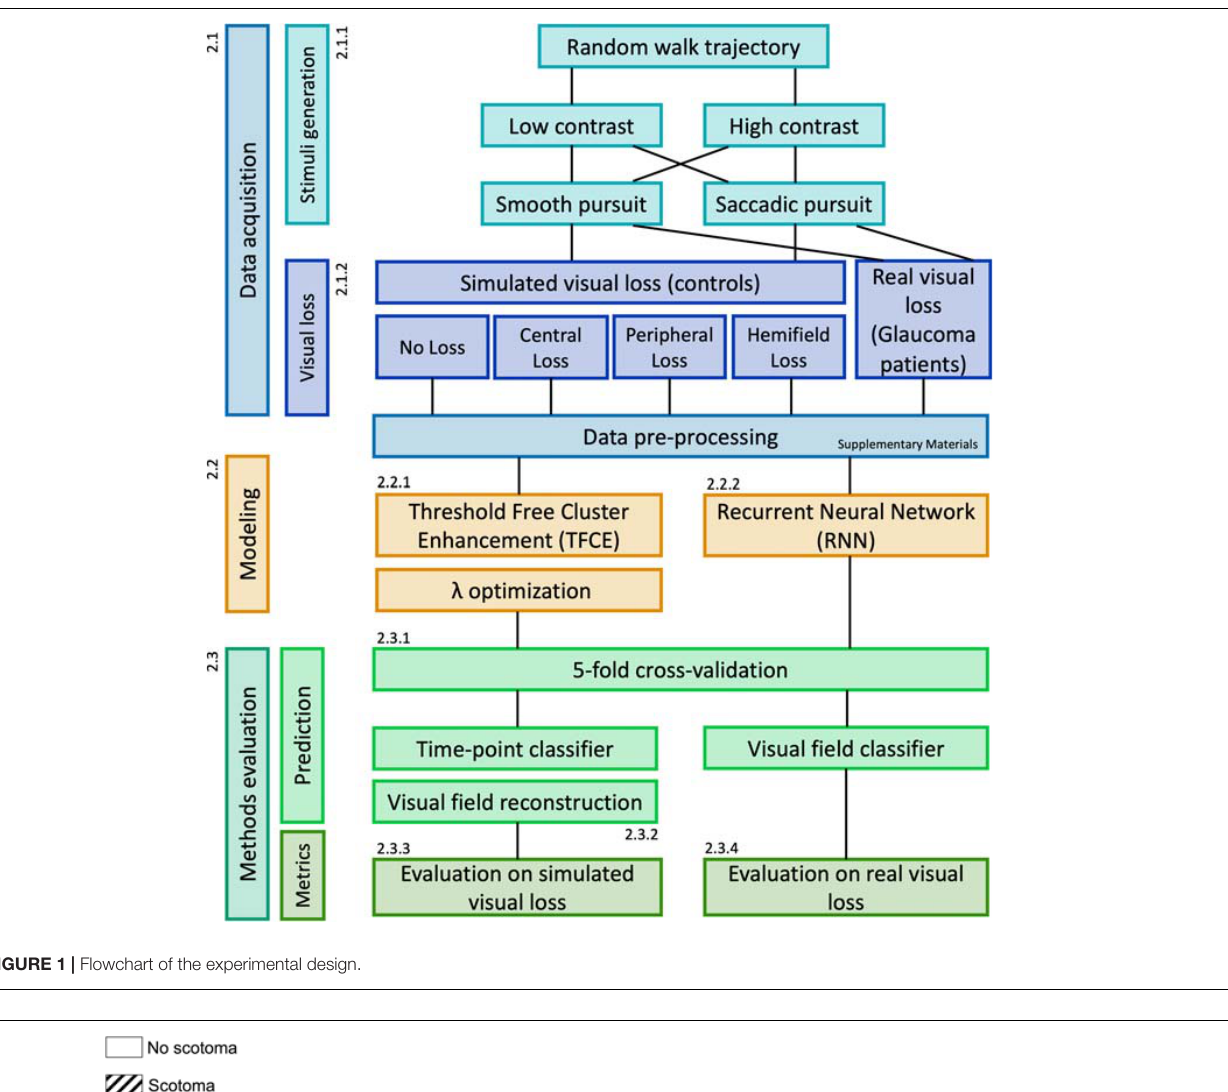
FIGURE 1 | Flowchart of the experimental design.